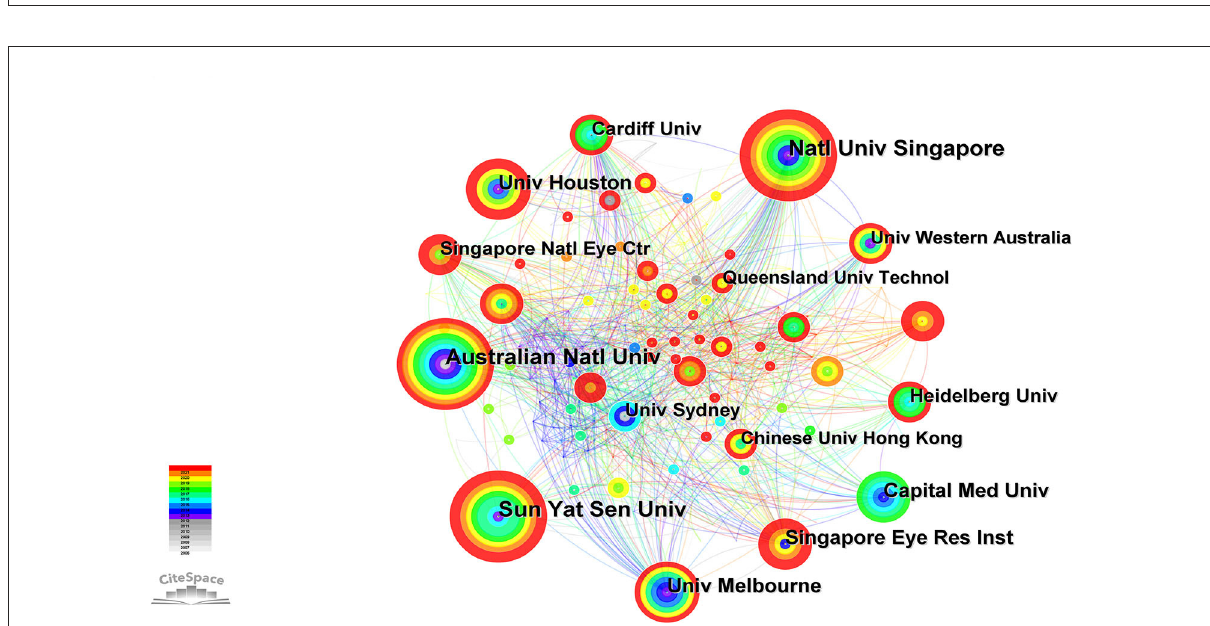
FIGURE5 Institutions of studies on the relationship between outdoor activities and myopia from 2006 to